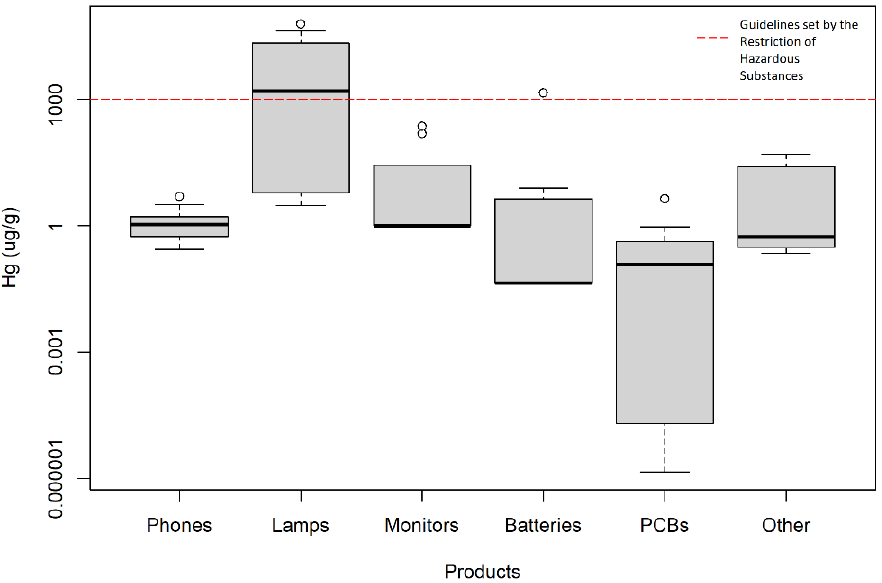
Figure 2. Central Tendency Values of Mercury in E-Waste Products. Results encompass data from 1103 e-waste products: phones (n = 89); lamps (n = 69); monitors, screens, and liquid crystal displays (n = 419); batteries (n = 235); printed circuit boards (n = 259); and other e-waste products (n = 32).